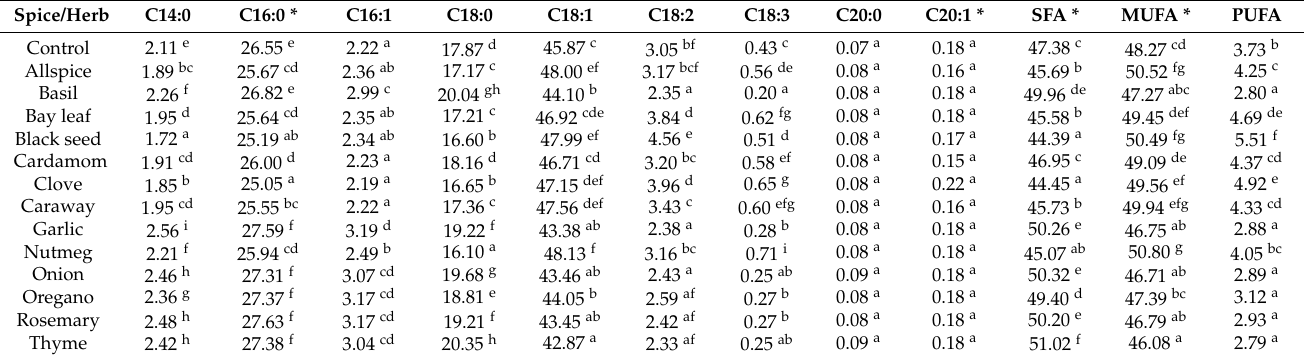
Table 3. Fatty acid composition (%) of raw beef neck during 13 days of storage at 4 ◦